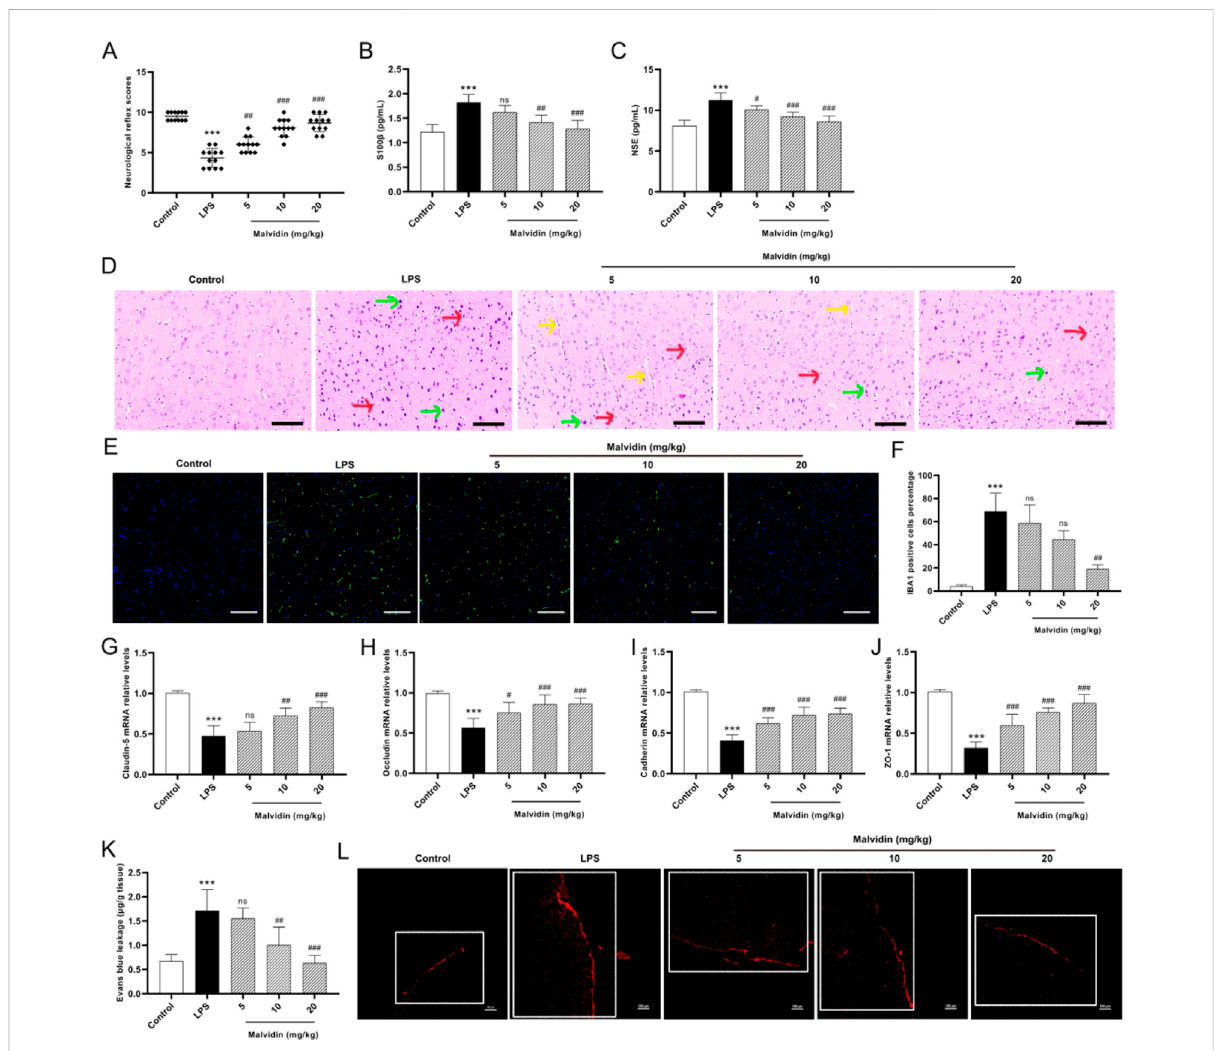
Effects of malvidin on LPS-induced mice cerebrum injury. (A) Scores of neurological re fl ex indicators of auricular re fl ex, corneal re fl ex, turn- right re fl ex, tail- fl ick re fl ex and escape re fl ex ( n = 12). (B – C) Serum S100 β and NSE levels analysis using ELISA assays ( n = 6). (D) Histopathological changes observations of cerebrum cortex using H&E staining ( n = 6). The red arrows represent neuronal necrosis, green arrows represent glial cells, and yellow arrows represent capillary dilation. (E) Immuno fl uorescence observation of glial cells activation in the cerebrum. The green fl uorescence signals are IBA1 positive cells, whereas the blue signals are cell nucleus. (F) Quantitative analysis of IBA1 positive cells percentage in cerebrum tissues ( n = 3). (G – J) The mRNA relative expression levels analysis of tight junction proteins of ZO-1, claudin-5, occludin, and cadherin using RT-qPCR analysis ( n = 6). (K) Quantitative analysis of evans blue leakage in cerebrum tissues under optical density values of 620 nm ( n = 6). (L) Confocal microscopeobservationofevans blueleakageinthecerebrum cortex(whitebox).Thered fl uorescencesignals areevansblue.Scalebar= 100 μ m * represents comparison between LPS group and control group, whereas # indicates analysis among LPS group and malvidin pretreatment groups. # is p < 0.05, ## is p < 0.01, ***/### is p < 0.001, and ns is p >